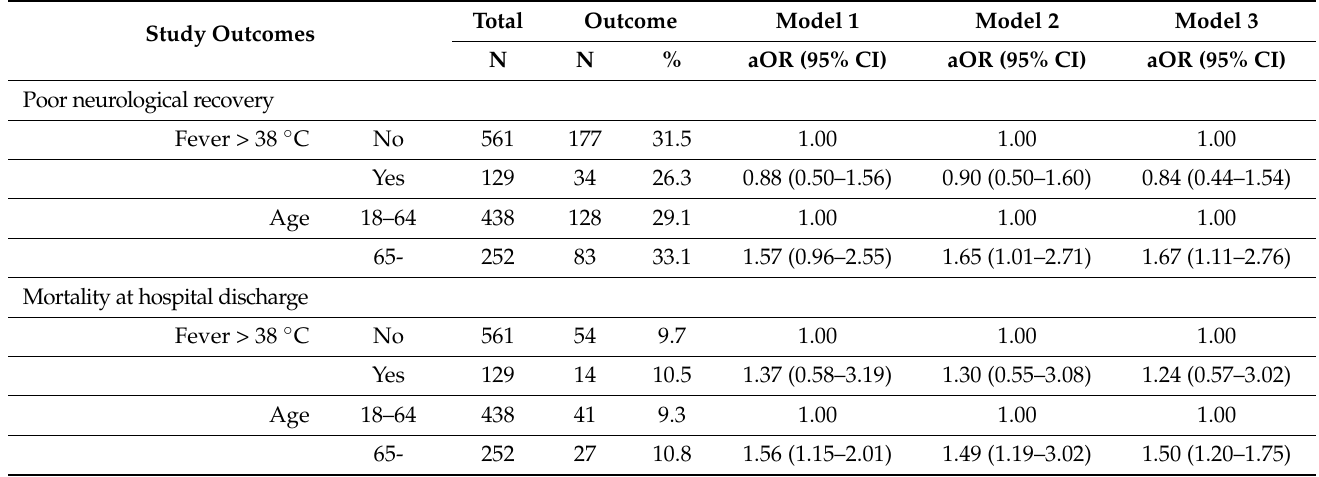
Table 3. Multivariable logistic regression model for study outcomes.